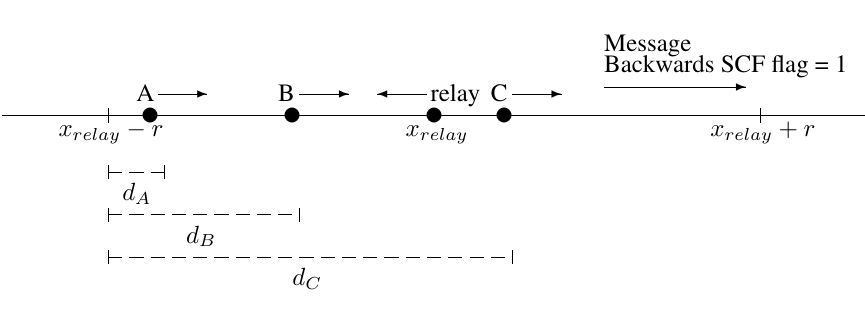
Figure 7. Selection of the best